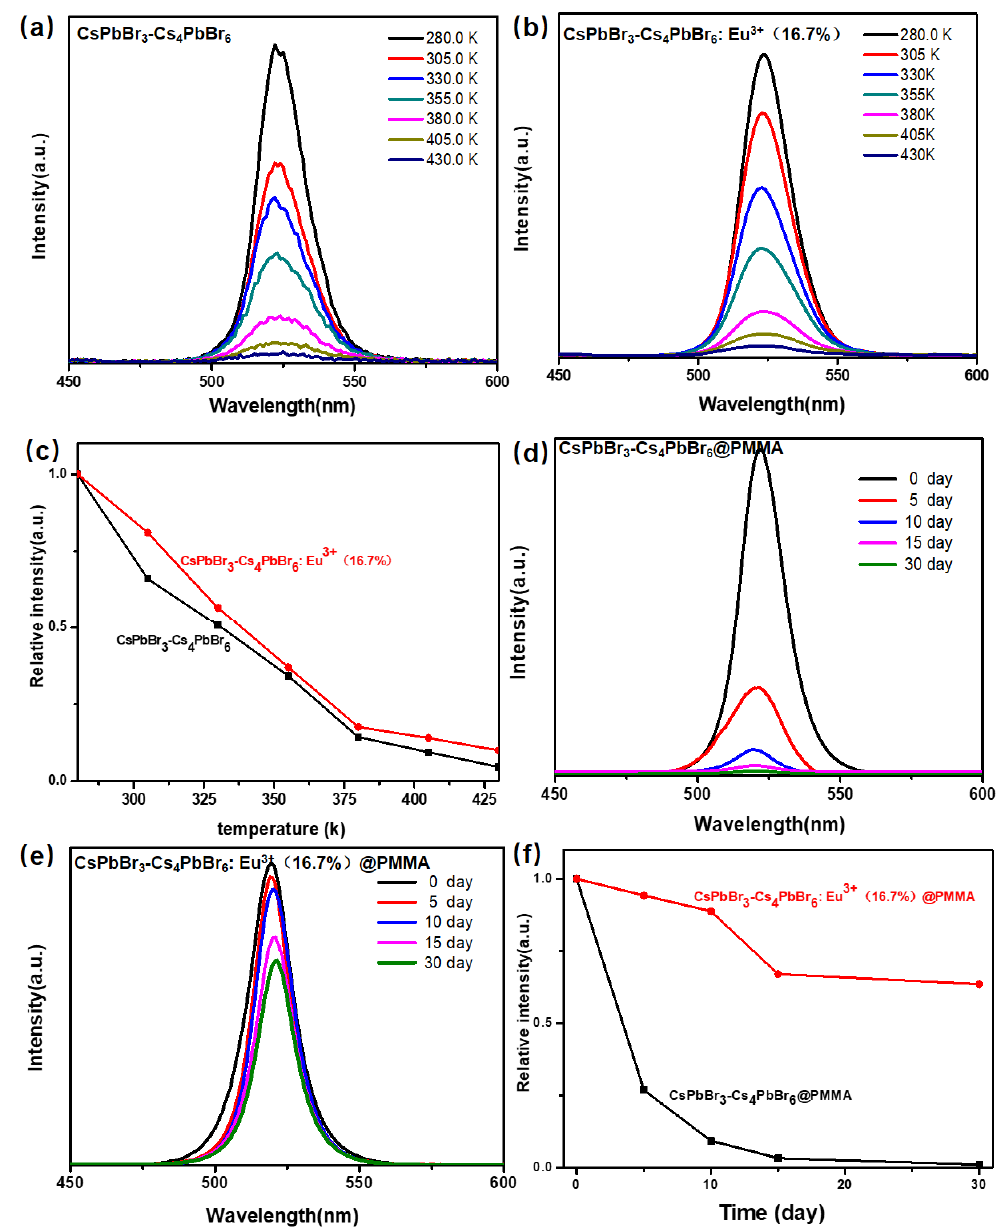
Figure 5. Temperature-dependent (280 K-430 K) PL spectra of ( a ) CsPbBr 3 /Cs 4 PbBr 6 composites and ( b ) CsPbBr 3 /Cs 4 PbBr 6 : Eu 3+ composites. ( c ) Relative PL intensity of undoped and Eu 3+ -doped CsPbBr 3 /Cs 4 PbBr 6 composites as a function of temperature. PL spectra of ( d ) CsPbBr 3 /Cs 4 PbBr